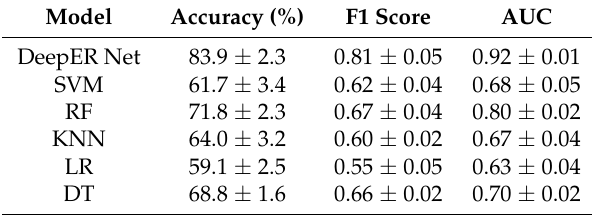
Table 4. Average metrics after five-fold cross validation. We used Equations (2) and (3) to calculate the average accuracy, F1 score, and AUC, as well as their standard deviations, and show these results as average ± standard deviation. Abbreviations : SVM, support vector machine; RF, random forest; KNN, k-nearest neighbors; LR, logistic regression; DT, decision tree; AUC, area under the ROC curve; ROC, receiver operating characteristic.